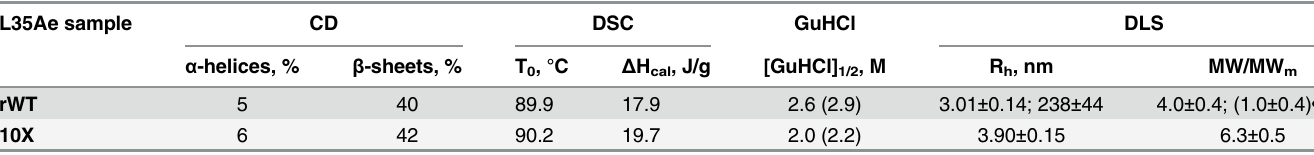
Table 2. Structural properties of L35Ae